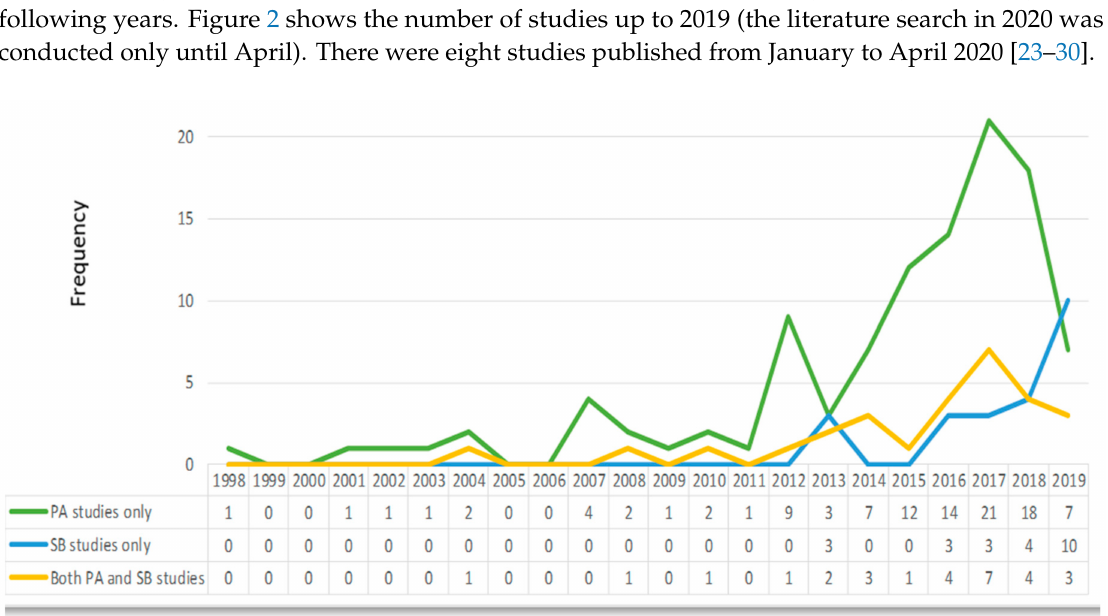
Figure 2. The number of included studies based on the topic, published per year